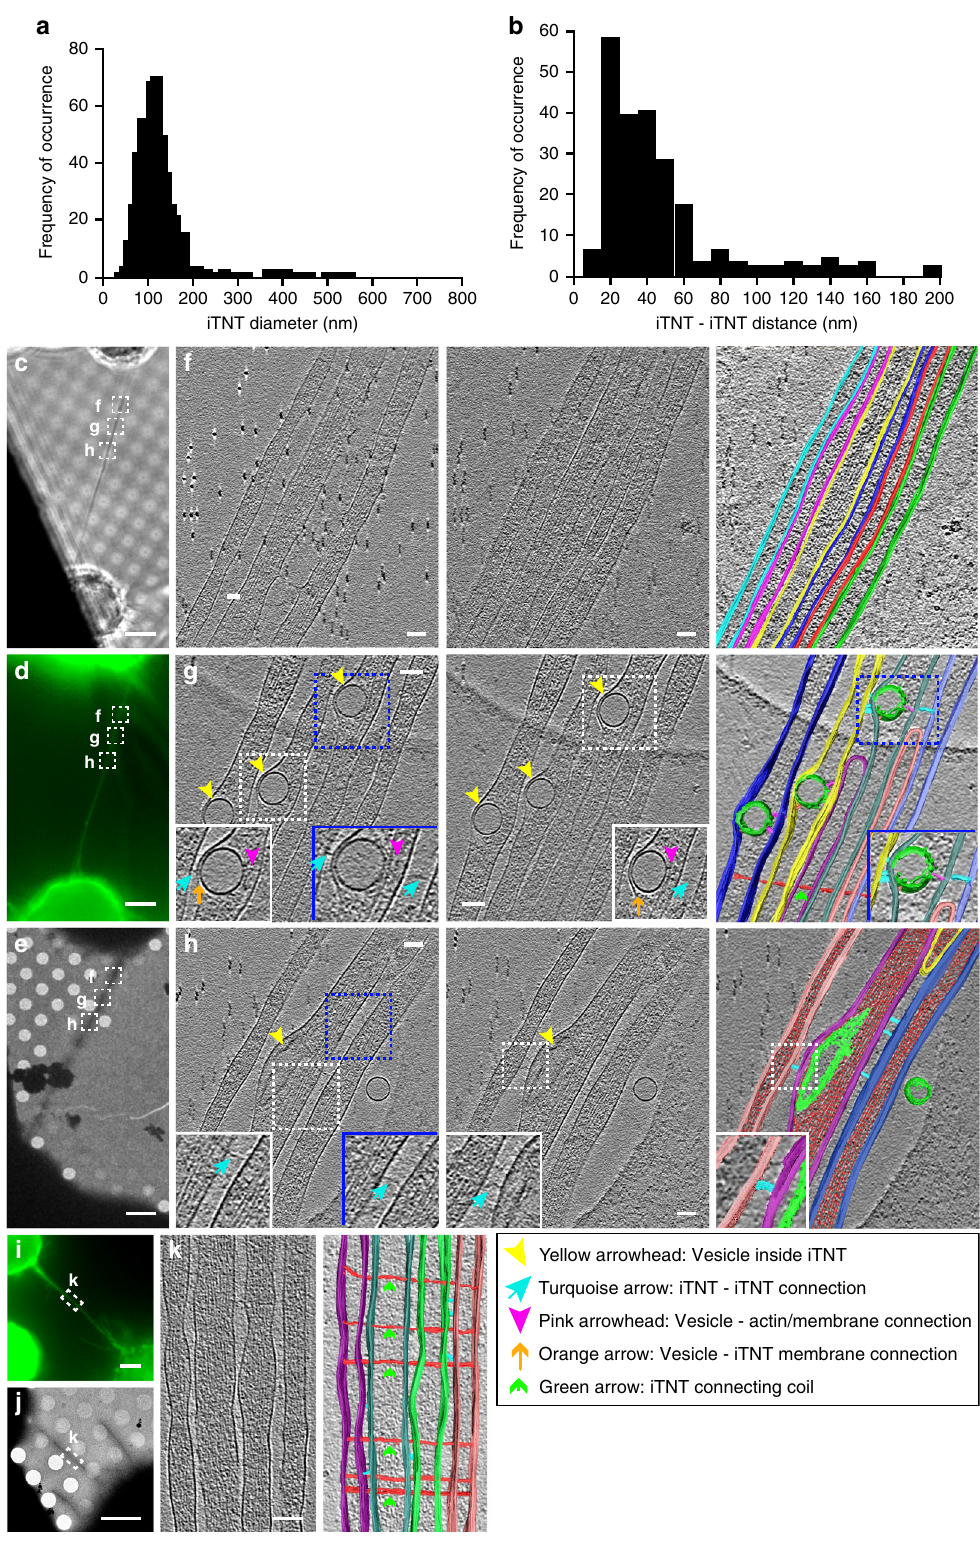
Yellow arrowhead: Vesicle inside iTNT Turquoise arrow: iTNT - iTNT connection Pink arrowhead: Vesicle - actin/membrane connection Orange arrow: Vesicle - iTNT membrane connection Green arrow: iTNT connecting